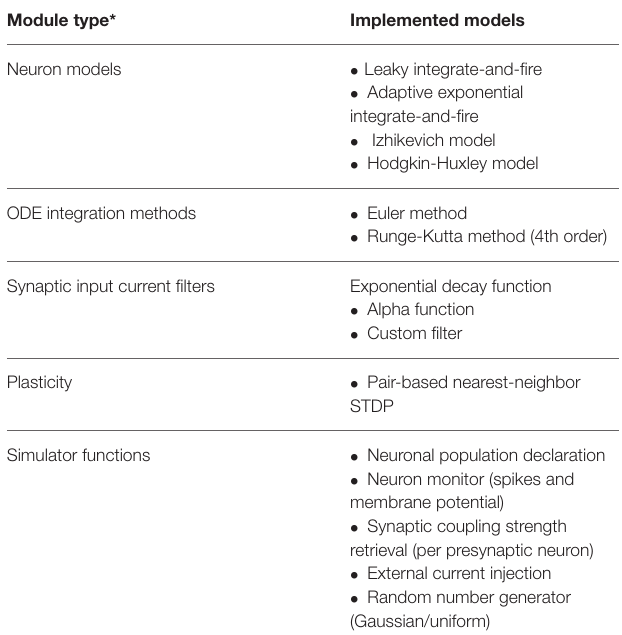
TABLE 1 | Summary of functionalities supported by